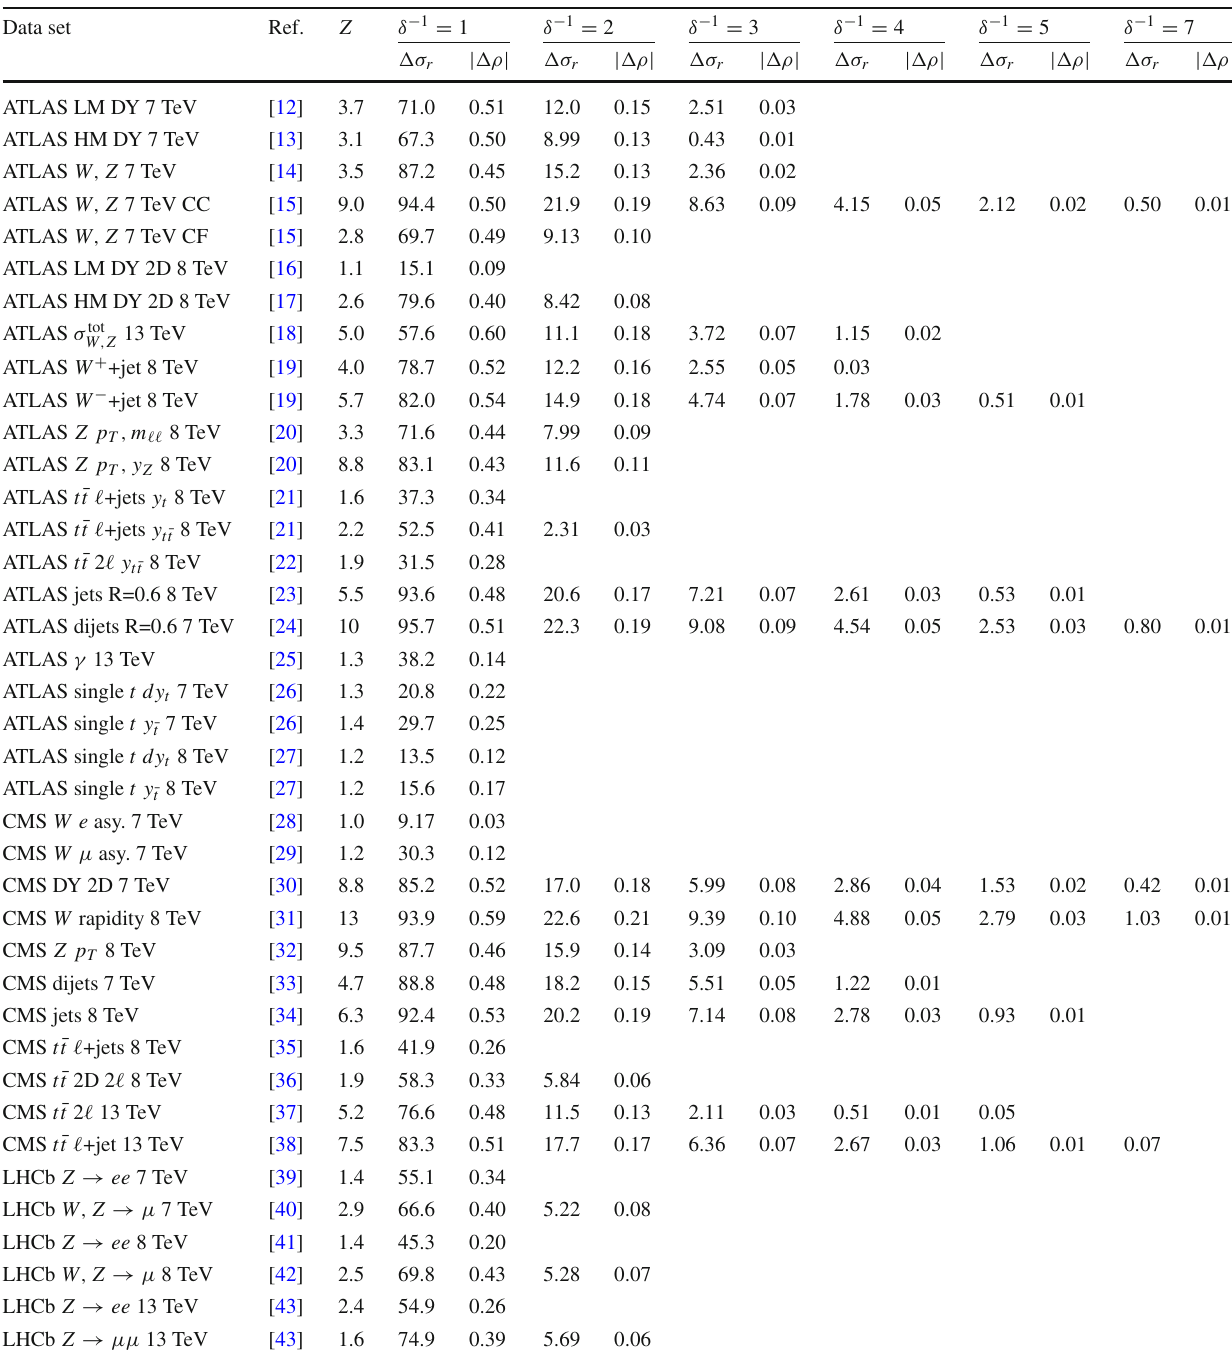
Table 1 The LHC measurements included in the NNPDF4.0 data set [9]. For each measurement we indicate its reference, the condition num- ber Z of the corresponding experimental covariance matrix, Eq (26), and the maximum relative difference of the variances (cid:6)σ r (in percent) and the maximum absolute difference of the correlation | (cid:6)ρ | computed between the nominal data set and the data set obtained by applying the